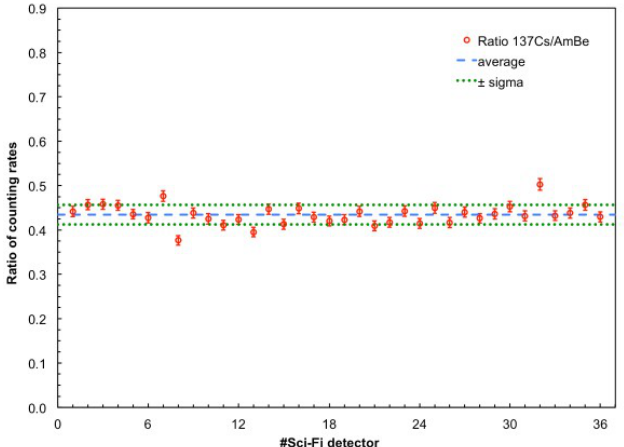
Fig. 11. Ratio between the observed counting rates respectively with the 137 Cs and the AmBe